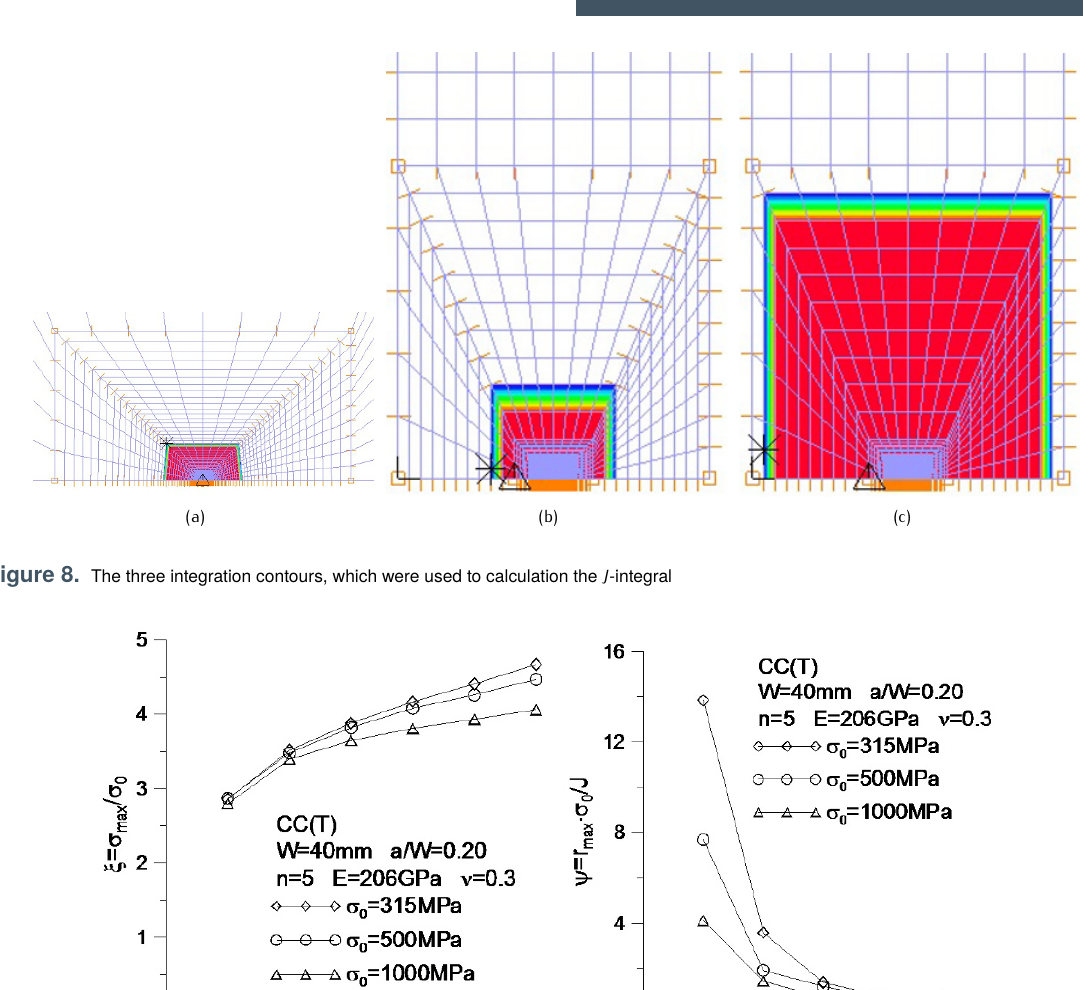
max /σ 0 (a) and their normalized location near crack tip ψ = r max ·σ 0 /J